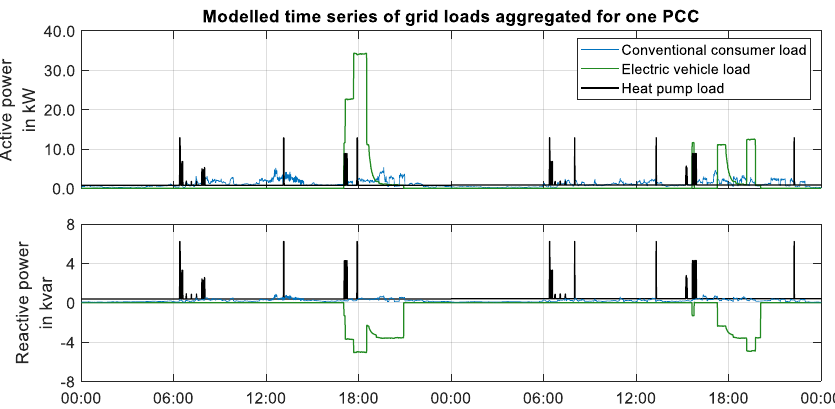
Figure 2. Modeled time series aggregated for one point of common coupling (PCC) supplying conventional consumers (three households), three electric vehicles charged at home as well as one heat pump.